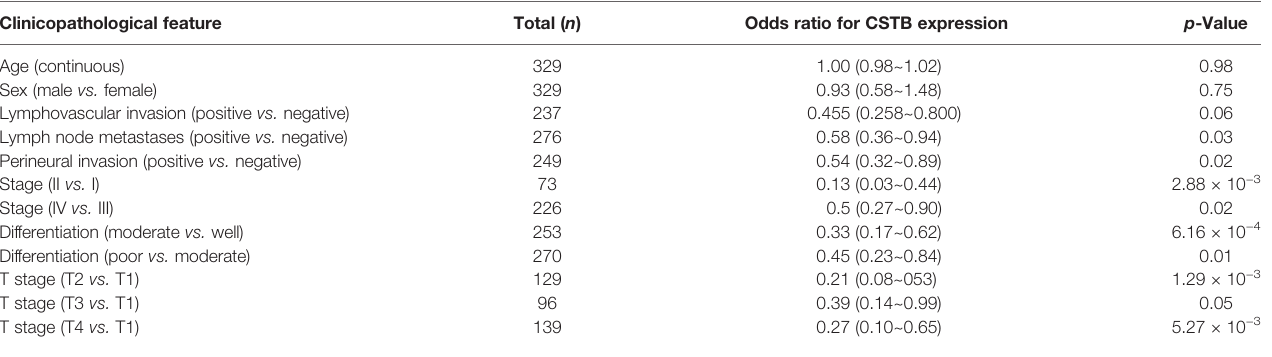
TABLE 2 | Association between CSTB expression and clinicopathological features. Clinicopathological feature